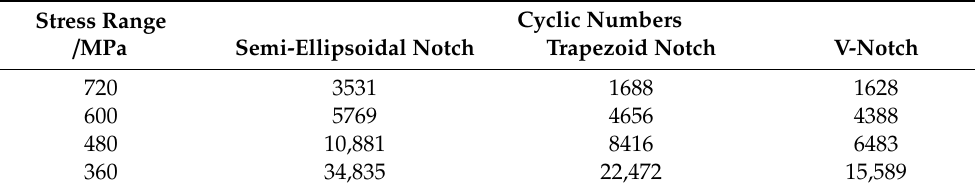
Table 7. The life of steel wire with machine-cut notches of di ff erent shapes.